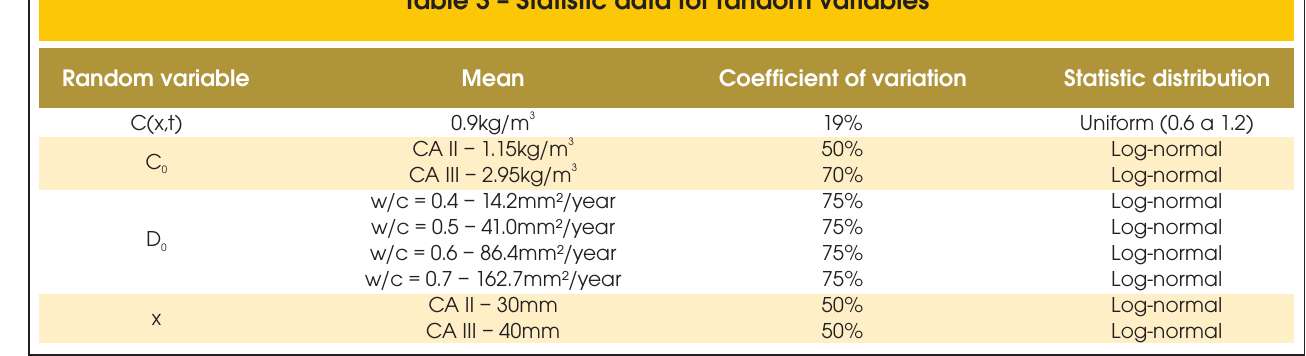
Table 3 – Statistic data for random